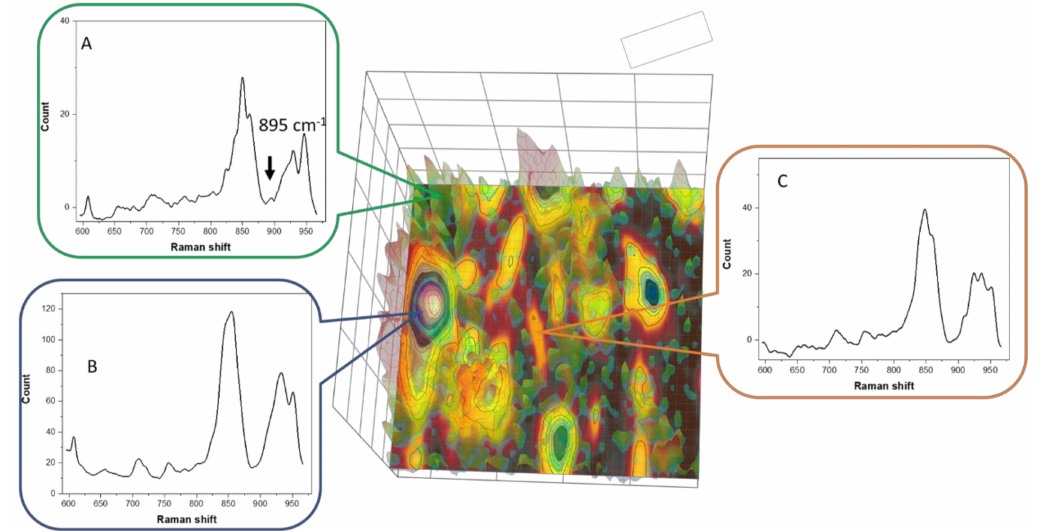
Figure 6. A combined Raman image from the spectral data for the chitosan region (Figure 5A) and the HPCD region (Figure 5B). Sample spectrum was shown for di ff erent highlighted spectral regions: ( A ) a chitosan rich domain, ( B ) a chitosan / HPCD mixed domain and ( C ) an HPCD rich